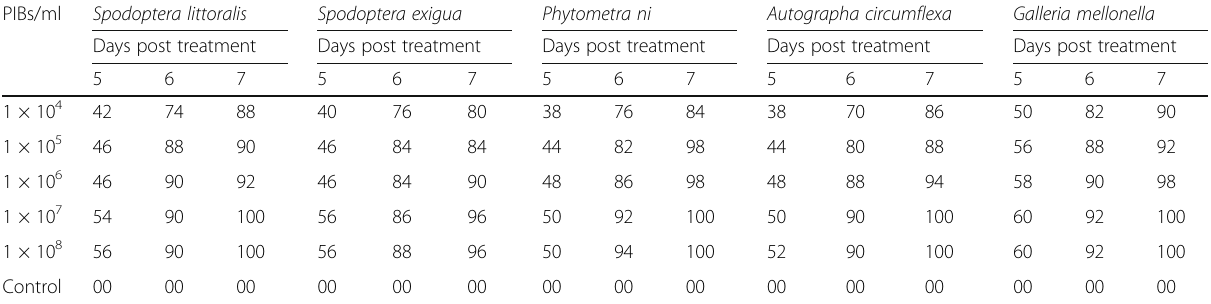
Table 2 Accumulated mortality % in 5 lepidopteran species fed on Spodoptera littoralis nucleopolyhedrosis virus extracted from droppings of Passer domesticus fed on diseased larvae PIBs/ml